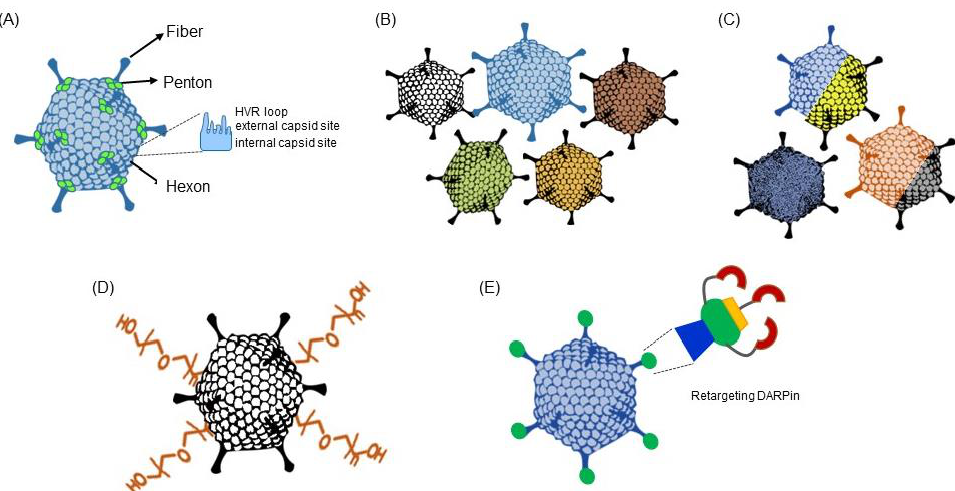
Figure 3. Strategies to improve AdV. ( A ) Genetic modification of viral capsid proteins (hexon, fiber, penton). The protein can either be exchanged by the respective protein of another Ad type or be mutated. ( B ) Adenovirus serotype switch. This strategy is based on vectorization of alternative human and non-human adenovirus types. ( C ) Directed evolution. Features can be enhanced by directed evolution using selection procedures after infection with a library of different Ad variants.